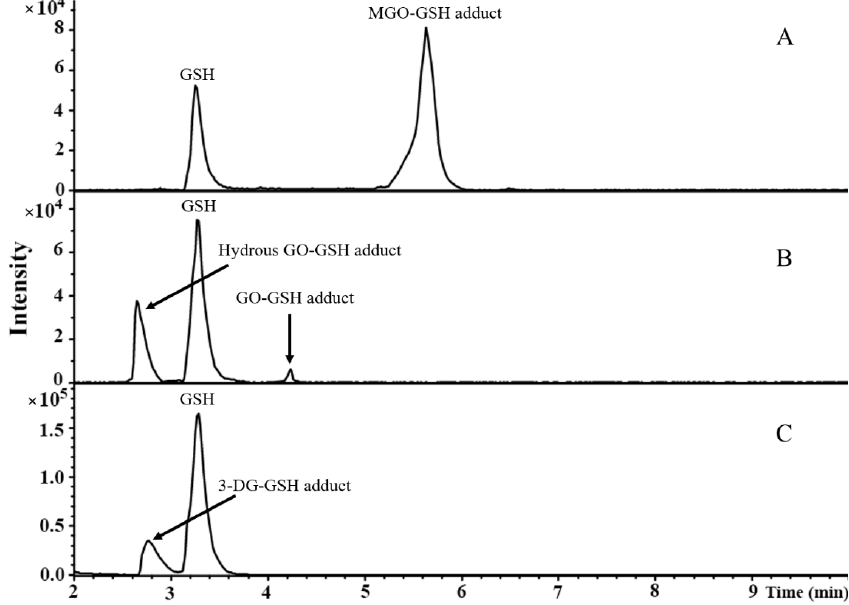
Figure 2. Typical LC ‐ TOF ‐ MS base peak chromatograms of incubations of MGO ( A ), GO ( B ), or 3 ‐ DG ( C ) with GSH at a molar ratio of 10:1 for 1 h.